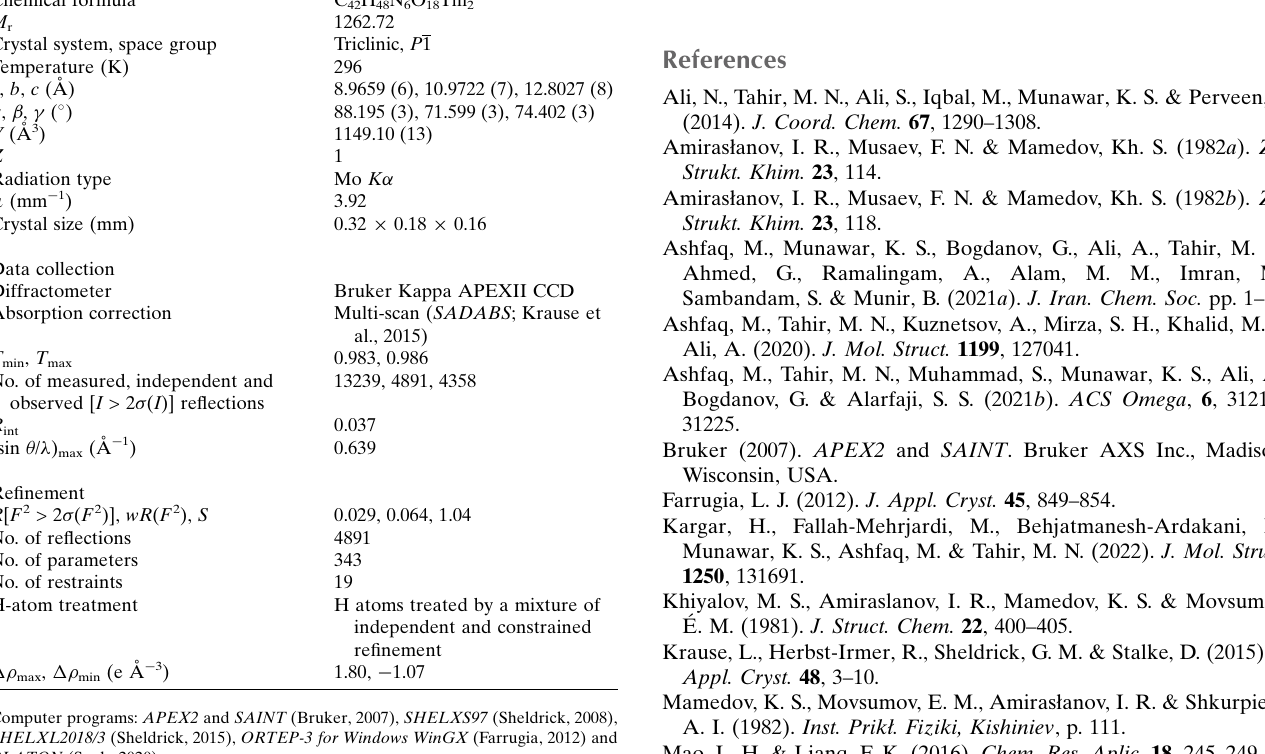
restraints (O—H = 0.82 A˚ , N—H = 0.85 A˚ ) with U 1.5U (O) or 1.2 U (N). All other H atoms were refined at eq eq calculated positions using a riding-model approximation [C— H = 0.93 A˚ , U (H) = 1.2 U (C)]. The highest positive and iso eq negative features in the final difference map are within 0.83 A˚ of the Tm atom.